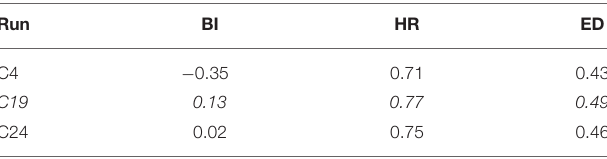
TABLE 1 | Best algorithm runs according to bias (BI), hit rate (HR), and Euclidian Distance (ED) statistical metrics.